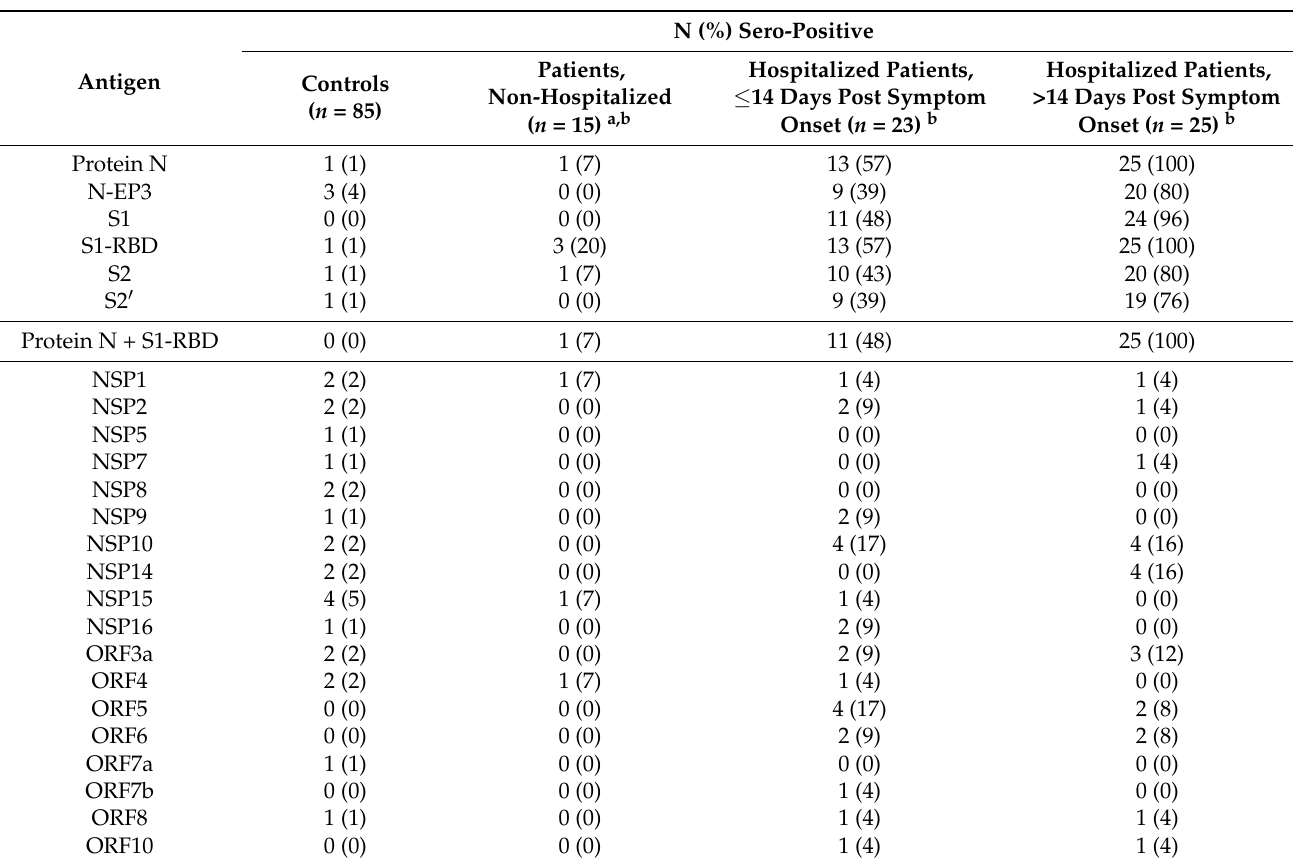
Table 2. Sero-prevalence of SARS-CoV-2 proteins in pre-pandemic controls, hospitalized, and non-hospitalized COVID-19